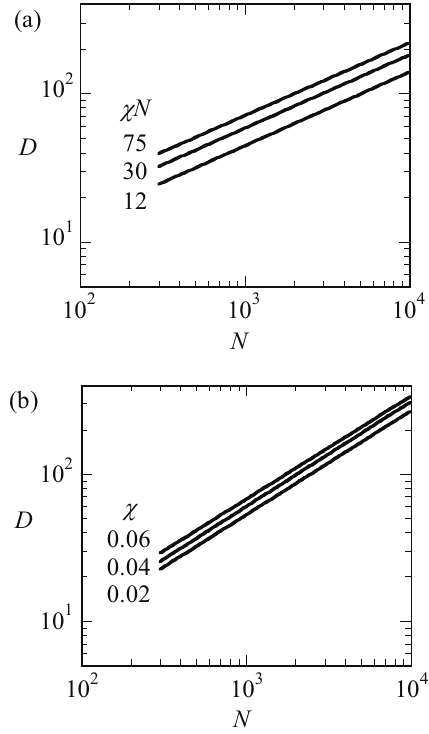
Figure 8. ( a ) The optimal spacing ( D ) as a function of the chain length ( N ) in lamellar phase for χ N values labeled next to the lines in double logarithmic coordinates. All lines have a slope of 1/2; ( b ) the optimal spacing ( D ) as a function of the chain length ( N ) in lamellar phase for fixed χ values that are labeled next to the lines in double logarithmic coordinates. All lines have a slope of